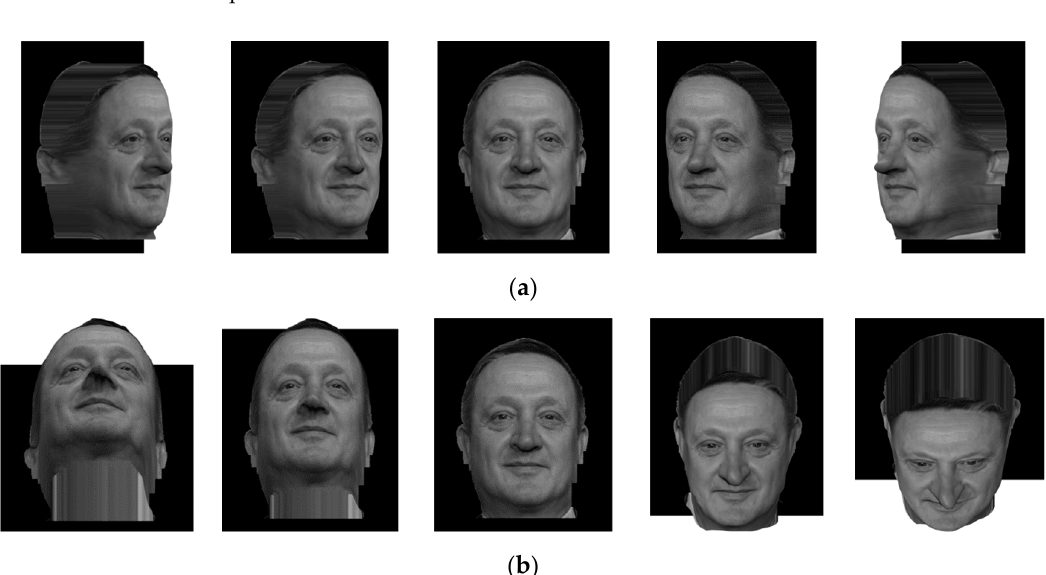
Figure 14. The living 3D object image is restored by the hologram: ( a ) horizontal parallax; ( b ) vertical parallax.